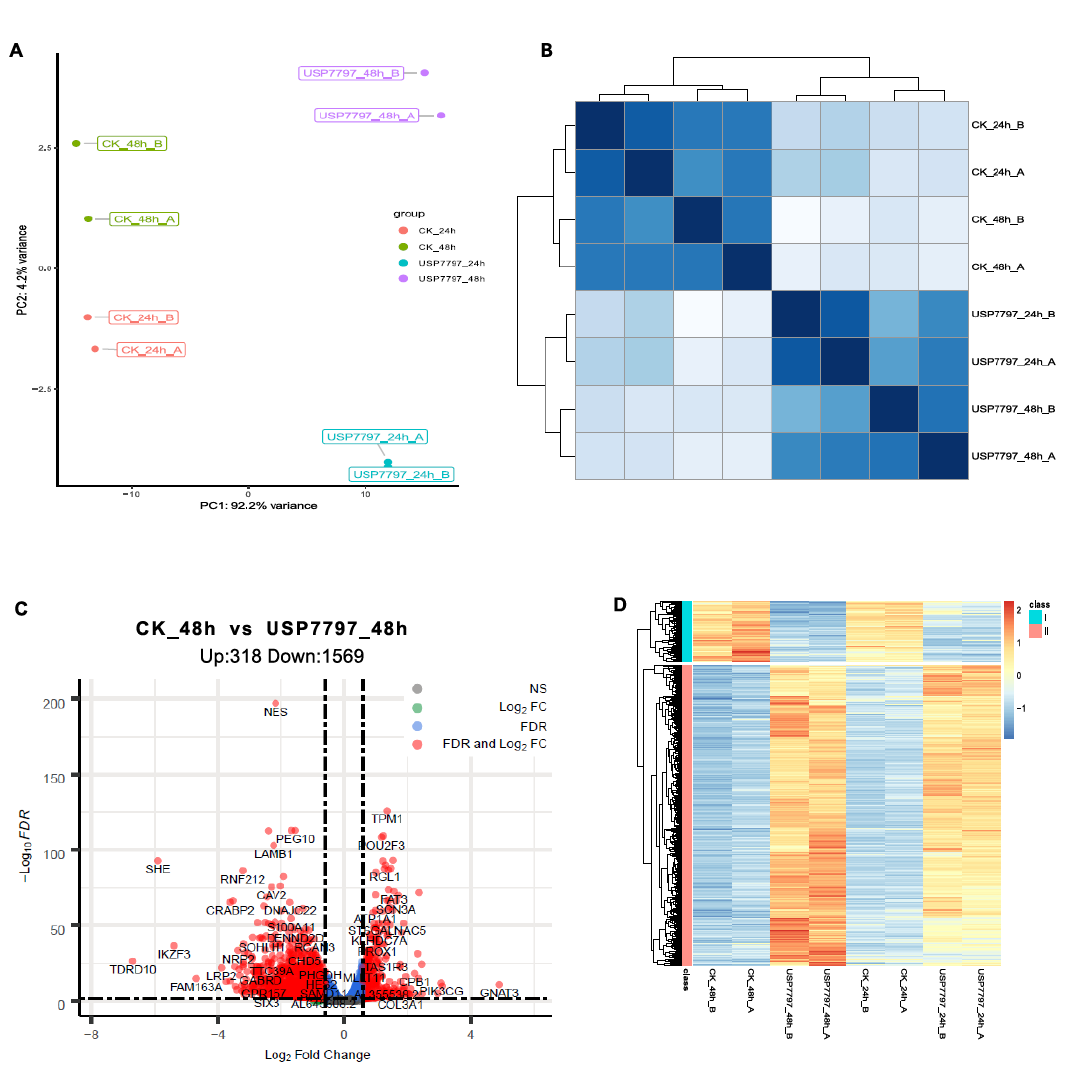
Figure 3. Exploratory and di ff erential expression analyses of RNA-seq data. ( A ) Principal-component analysis of sample relationship. ( B ) Poisson distance plot of sample dissimilarities in terms of transcriptomic profiles. ( C ) Volcano plot of shrunken log 2 (fold change) and –log 10 FDR of all tested genes between vehicle-control (CK) samples and samples treated with USP7797 at 48 h post treatment. Genes with | log 2 (fold change) | > log 2 (1.5) and FDR < 0.05 (significantly di ff erentially expressed genes) are in red, genes with | log 2 (fold change) | > log 2 (1.5) but FDR ≥ 0.05 are in green, genes with | log 2 (fold change) | ≤ log 2 (1.5) but FDR < 0.05 are in blue, and the rest are in gray. ( D ) Heatmap showing significantly di ff erentially expressed genes which are represented by red dots in ( C ).